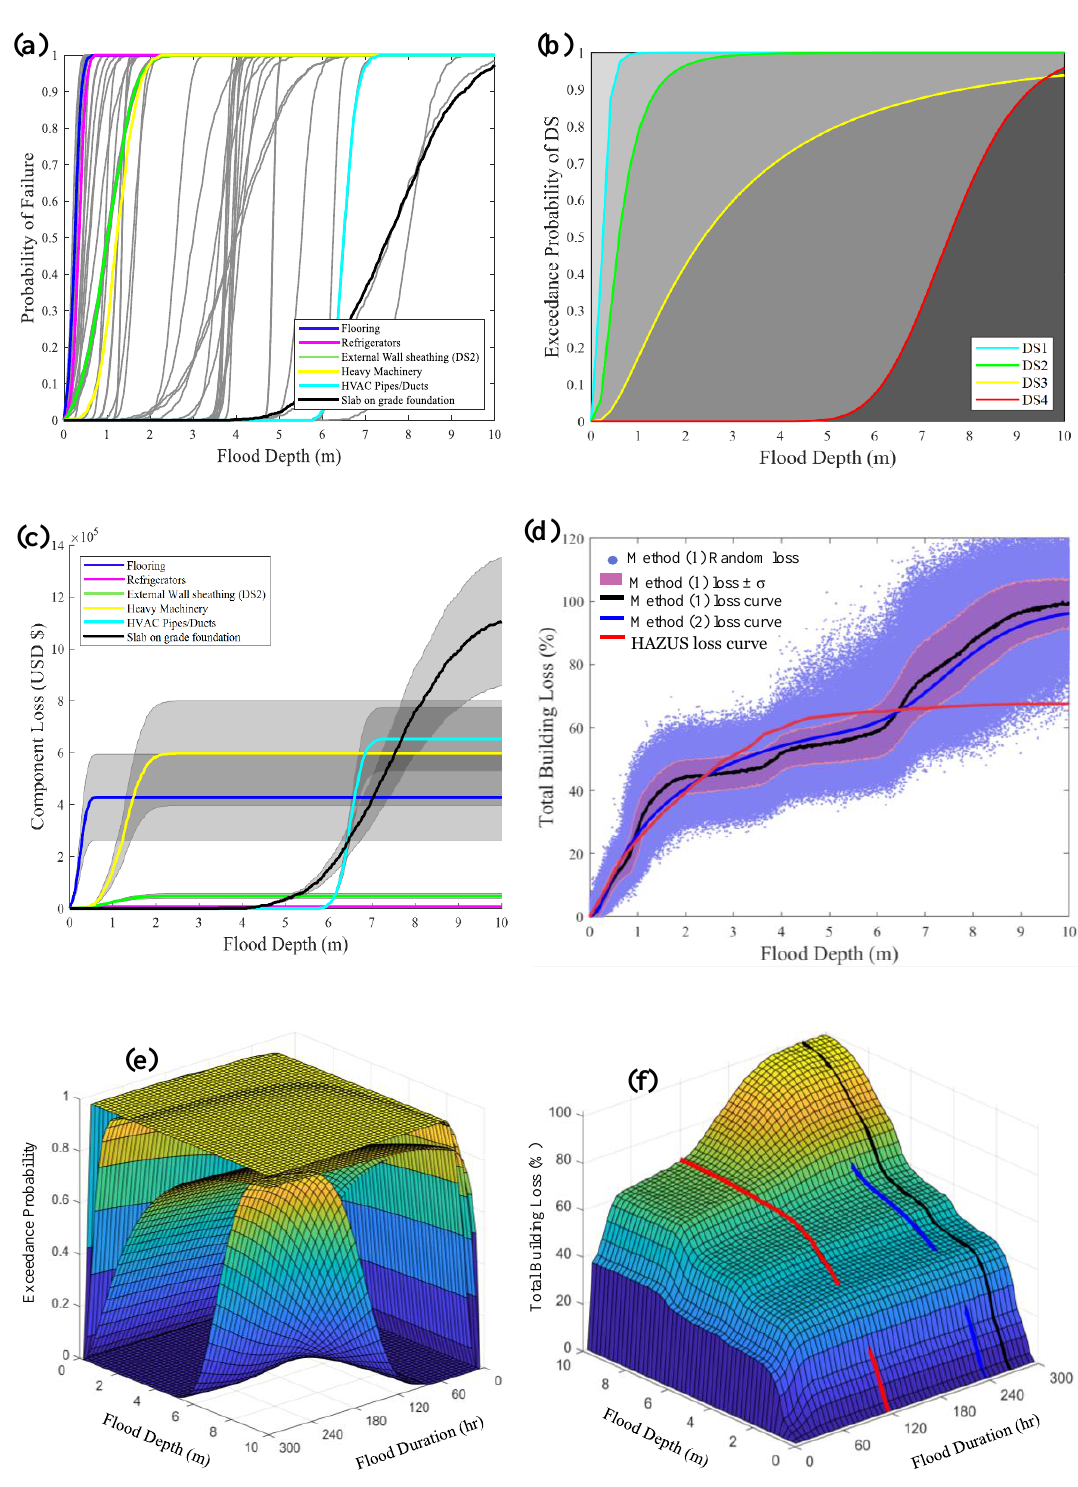
Figure A23. F9 archetype analysis results: ( a ) Component fragility curves; ( b ) Building fragility curves; ( c ) Selected components’ loss curves; ( d ) Building loss curves; ( e ) Building fragility surfaces; ( f ) Building loss surface.